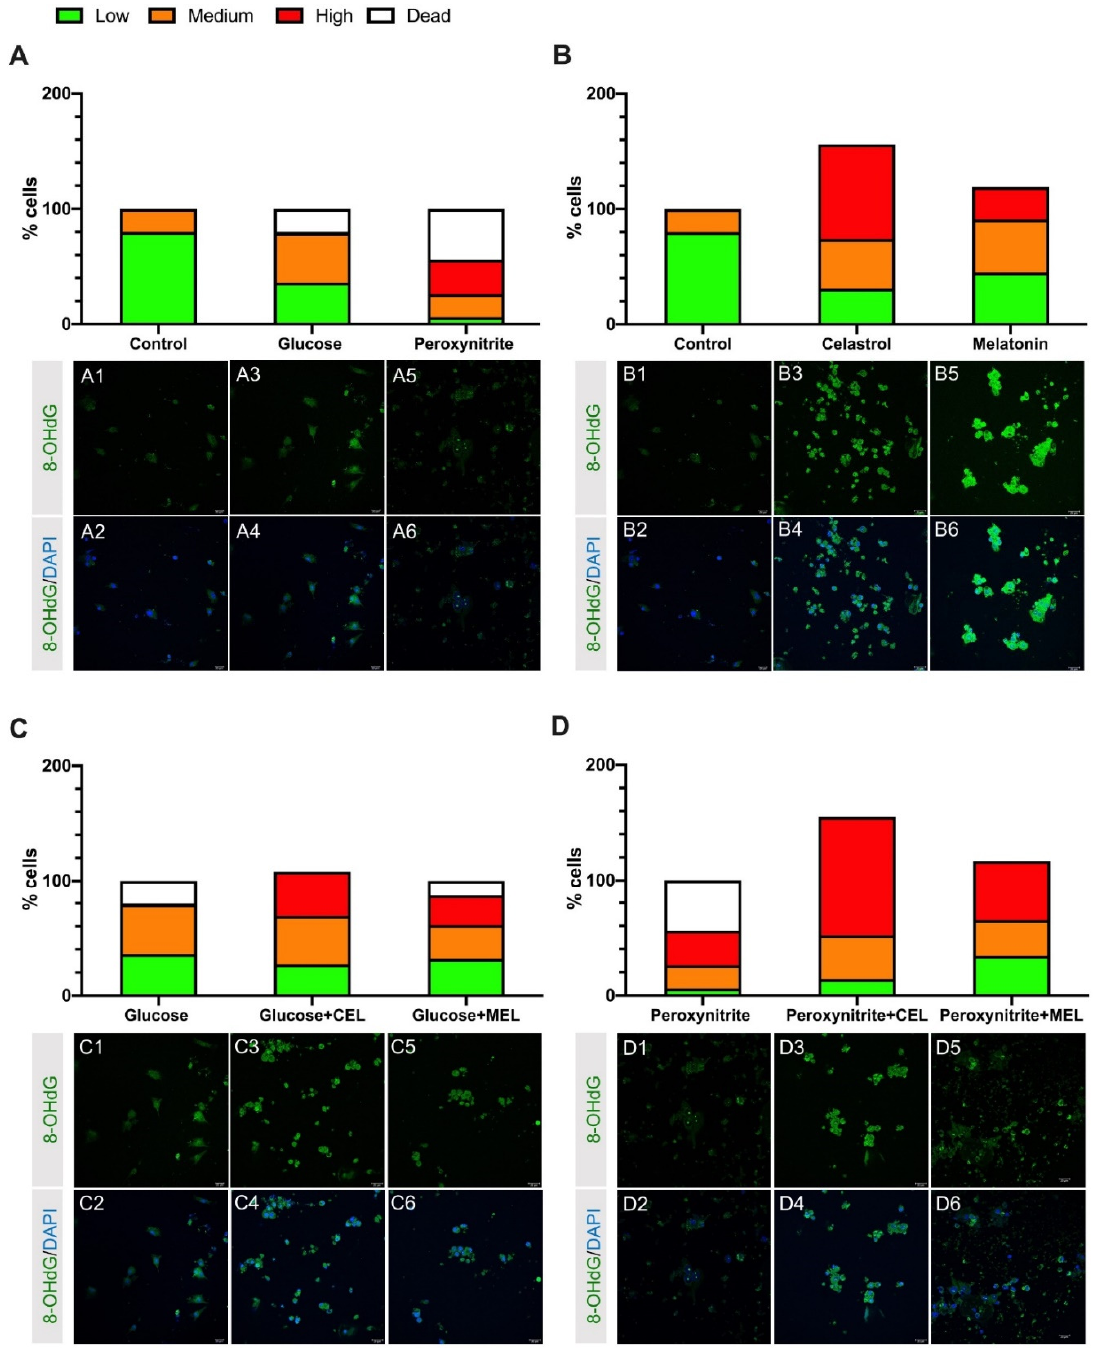
Figure 1. Effect of glucose, peroxynitrite, celastrol (CEL), melatonin (MEL) and their combinations on DNA damage and cell survival in hGL cells. Histograms represent percentage of cells with different 8-OHdG staining intensity defined as low (green), medium (orange) and high (red). Percentage of dead cells is included (white). Representative images of each culture condition are showed below corresponding bar. ( A ) Glucose and peroxynitrite treatments compared to control. ( B ) Celastrol and melatonin compared to control. ( C ) Glucose + CEL and glucose + MEL treatments compared to glucose treatment. ( D ) Peroxynitrite + CEL and peroxynitrite + MEL treatments compared to peroxynitrite treatment. n = 3.